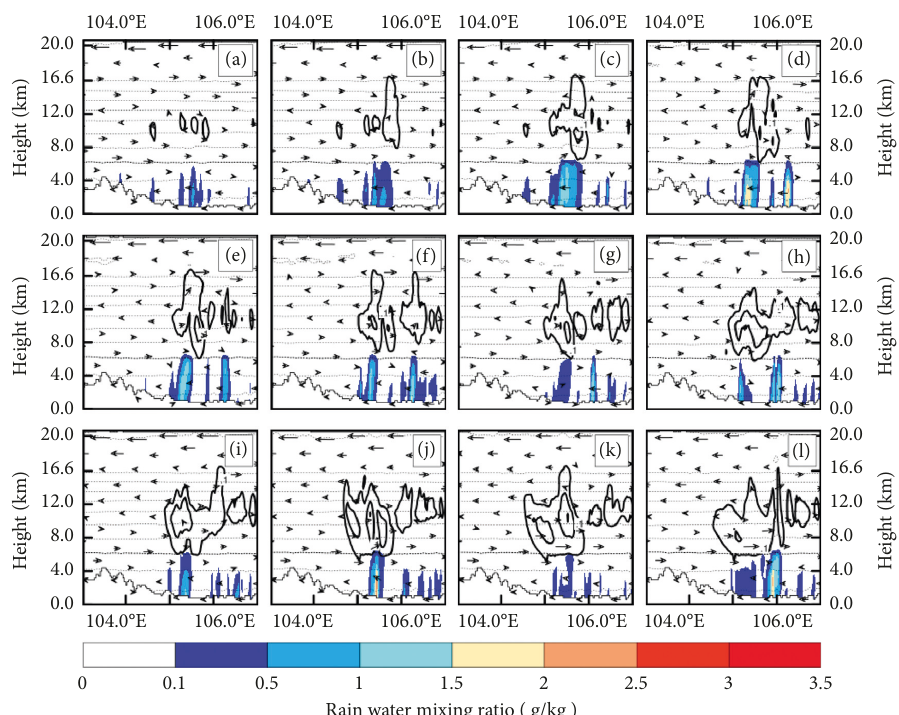
Figure 9: Longitude-height cross section of rain and snow mixing ratio at 32.1 ° N; the mixing ratio of rain is represented by shade color; the mixing ratio of snow is represented by solid lines (start value: 0.0001g/kg; interval: 0.5 g/kg from 0.1 to 3.1 g/kg); the wind vector is represented by arrows; the thick dotted line is the 0 ° C isotherm on June 27: (a) 13:00; (b) 13:30; (c) 14:00; (d) 15:00; (e) 15:30; (f) 16:00; (g) 17:00; (h) 18:00; (i) 19:00; (j) 20:00; (k) 21:00; (l) after 15:00 UTC, reaching a height of 12 km. New convective cells also form around this location and develop with time.